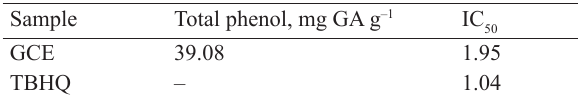
Table 1 Total phenolic content and IC (GCE) and TBHQ Sample